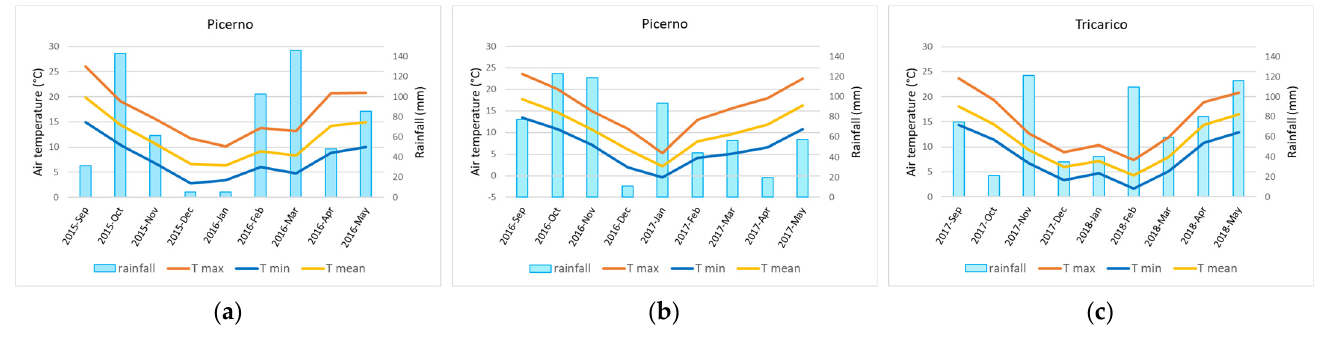
Figure 2. Meteorological data recorded in the area of experimental sites in the three different years: